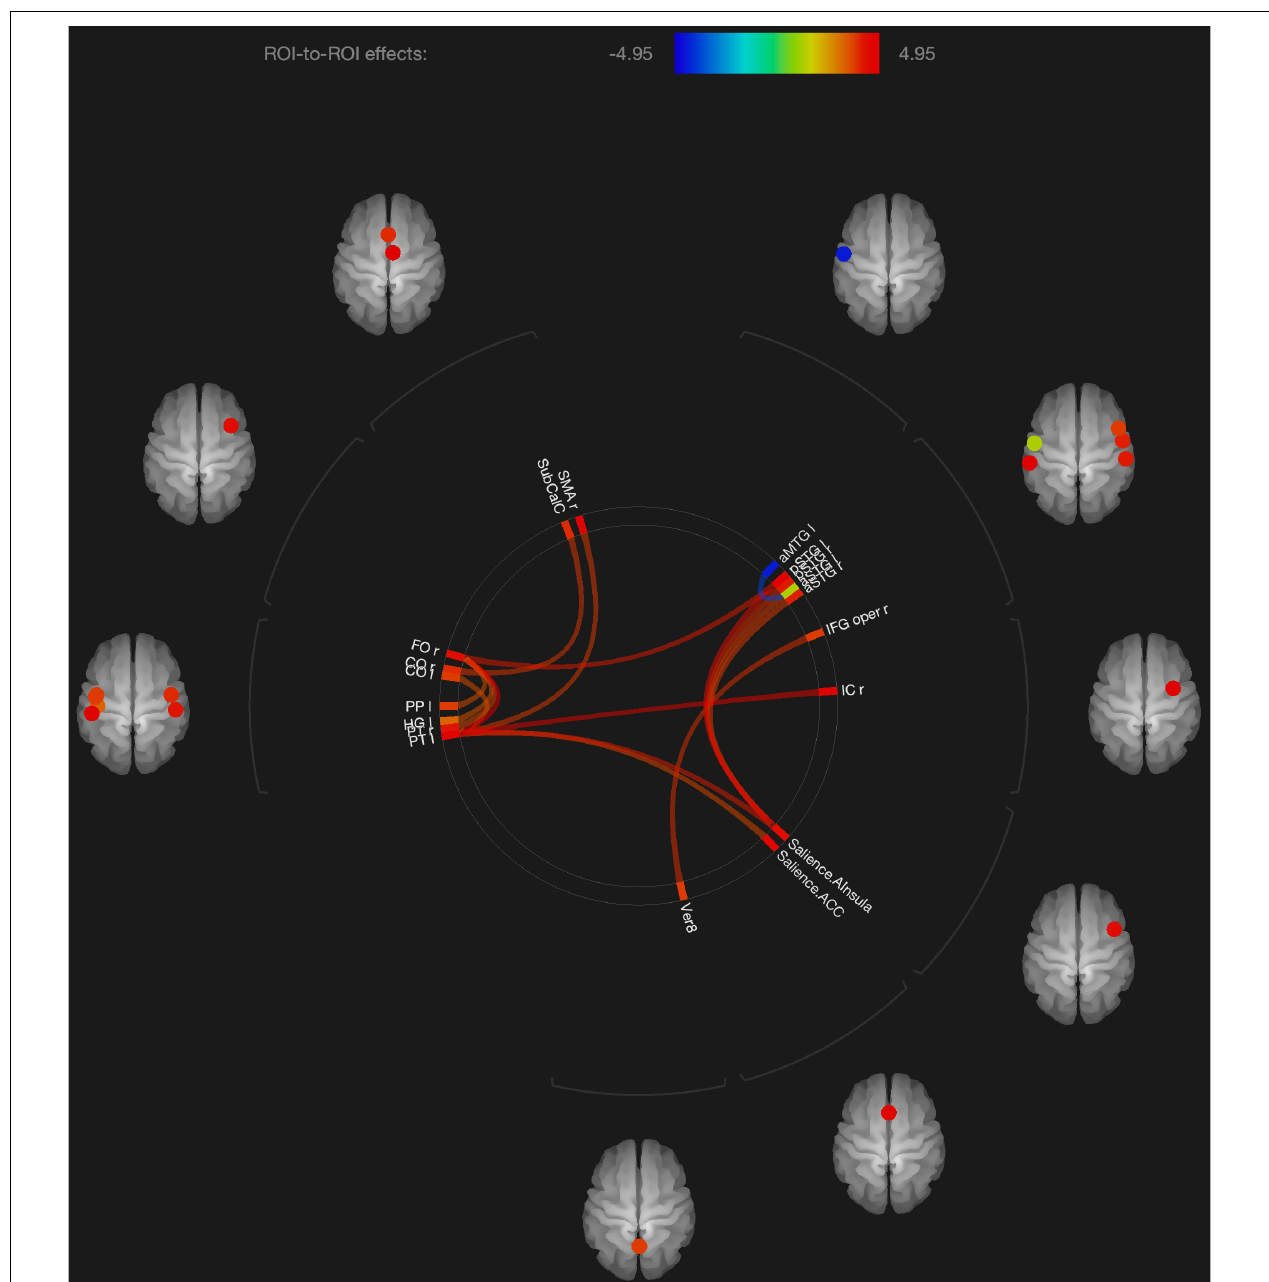
FIGURE 1 | Visualization of ROI-to-ROI connections comparing orgasmic meditation (OM) and neutral groups among all the participants, p -FDR corrected <